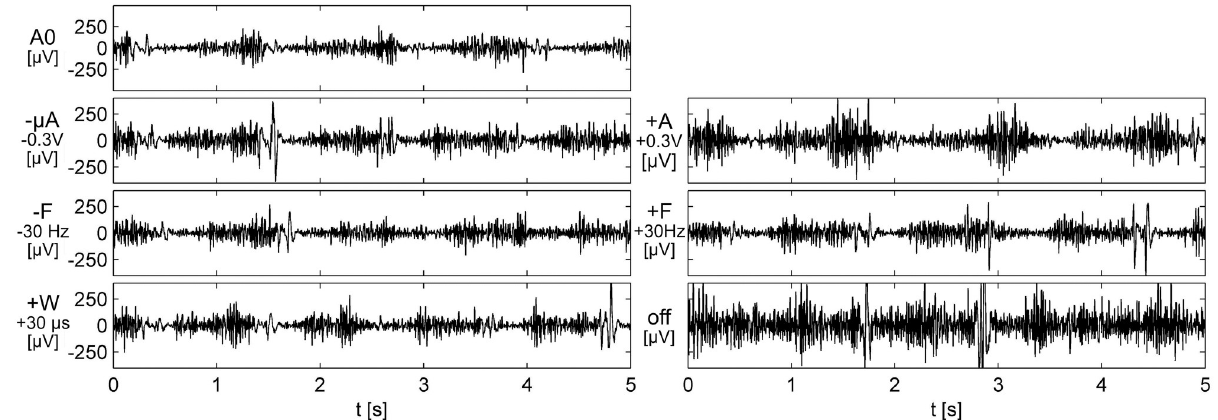
Fig 1. The EMG signals of one patient during the elbow flexion-extension task during the adjustment of DBS. The morphology of the EMG signal differs among the different adjustments of DBS. Turning the stimulator off caused the strongest effect and introduces significant tonic background to the EMG signal. Scaling is identical in all settings.